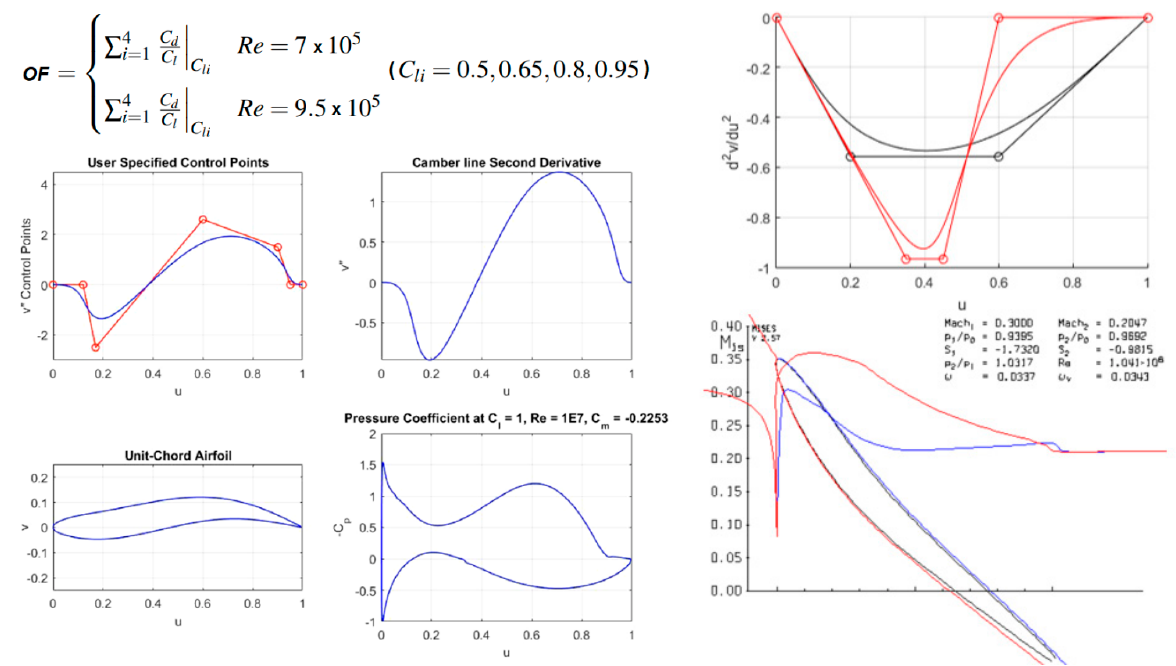
Figure 33. Objective function, curvature-driven meanline for an example airfoil with C p from XFOIL run in the design cycle, and control diffusion airfoil showing an S-shaped geometry.